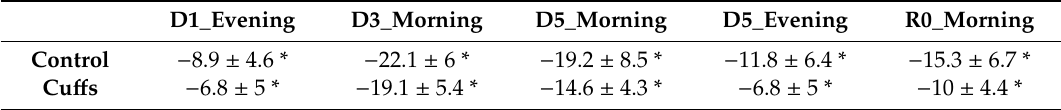
Table 1. Plasma volume changes as a percentage of baseline (mean ± SD). * p <